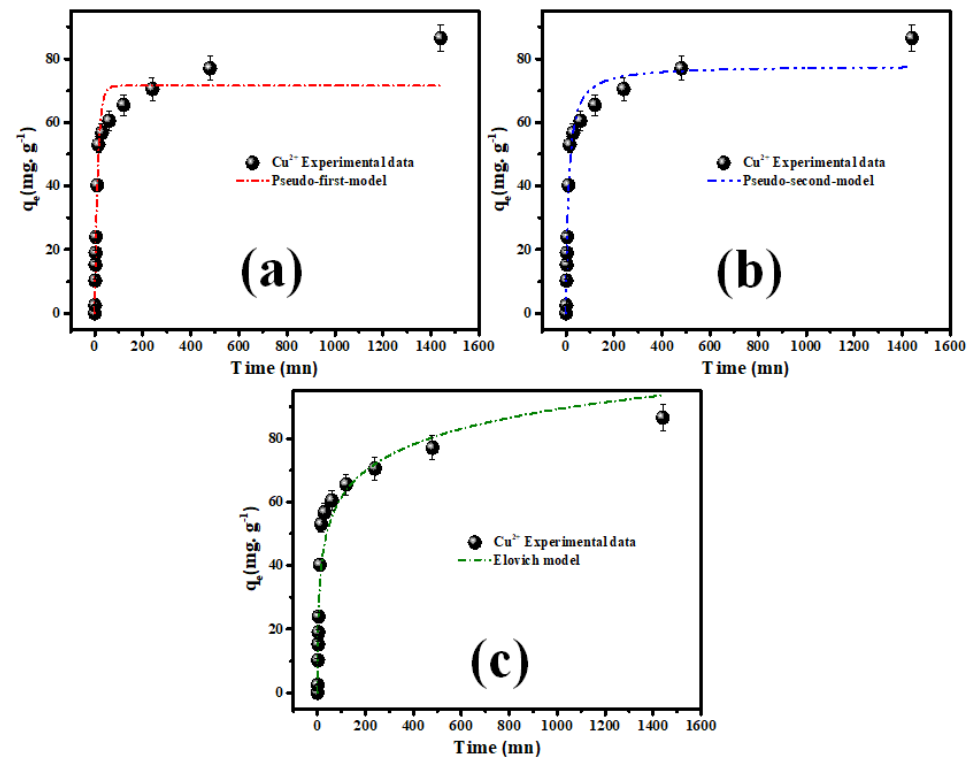
Figure 7. Nonlinear graphs: ( a ) PFO; ( b ) PSO; and ( c ) Elovich kinetics models for Cu (II) ions adsorption onto the fabricated MgY 2 O 4 @g-C 3 N 4 nanomaterials. Table 2. Calculated kinetic model parameters for Cu (II) adsorption on MgY 2 O 4 @g-C 3 N 4 nanomateri- als.